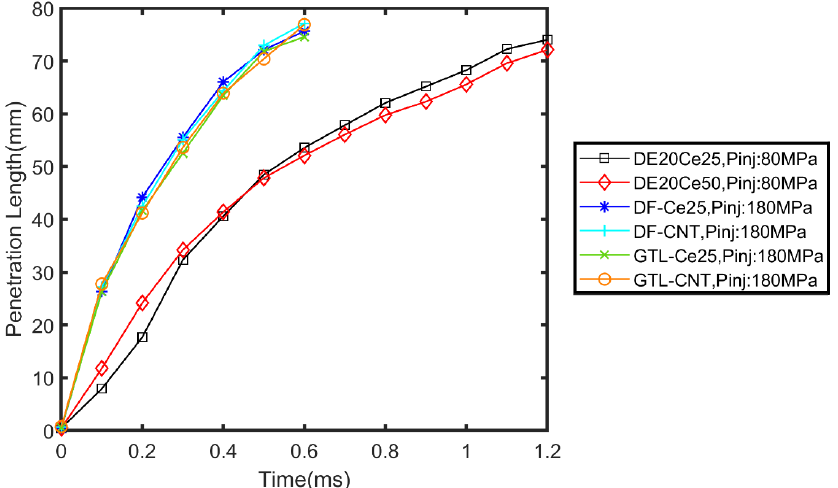
Figure 16. PL with nano additives at 1 MPa ambient and different injection pressures [43,122].